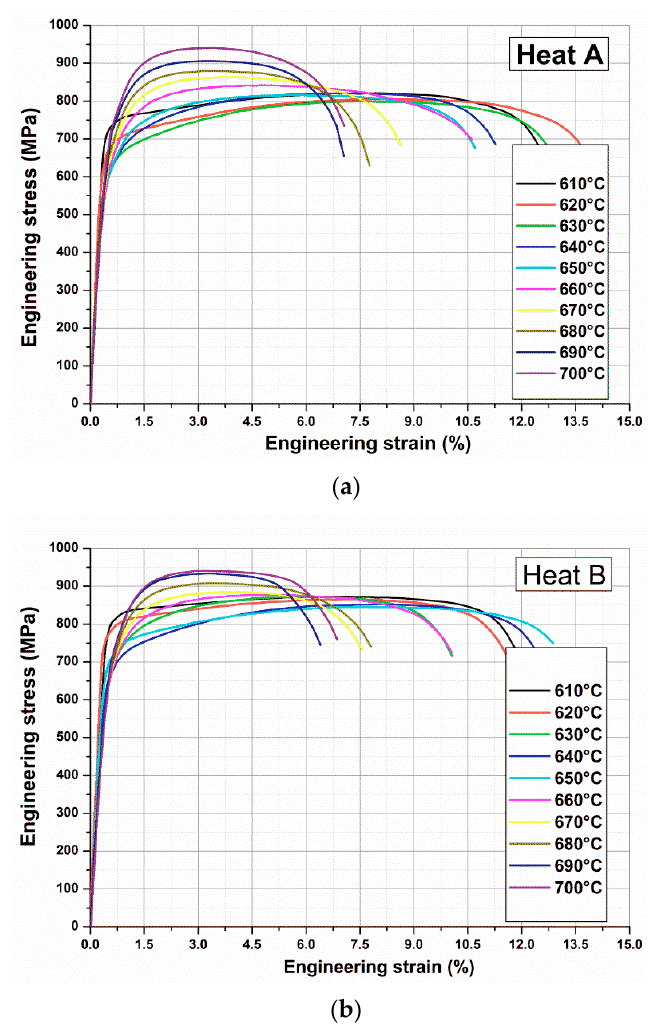
Figure 5. Experimental stress–strain curves of ( a ) Heat A and ( b ) Heat B after single tempering at different temperatures.